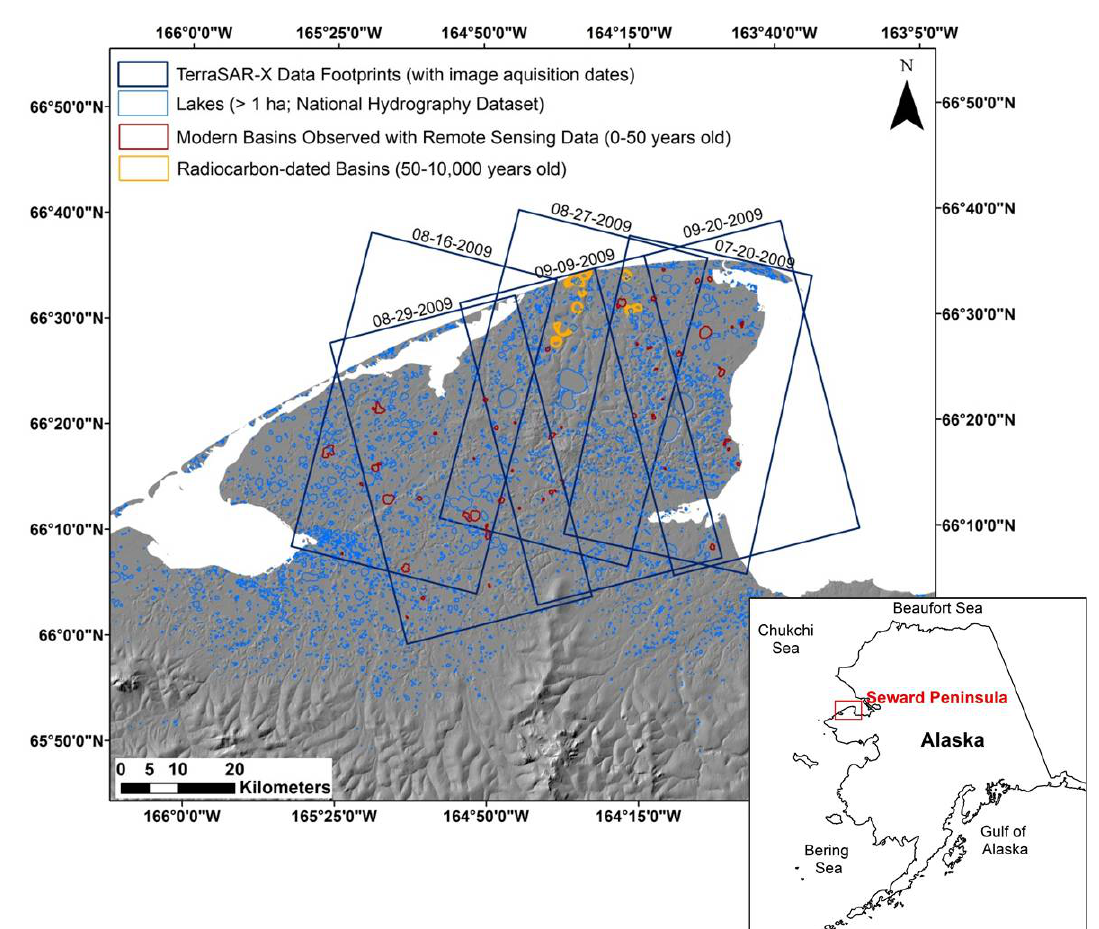
Figure 1. Digital Elevation Model (DEM) base map of the Seward Peninsula showing the location of lakes (>1 ha) mapped in National Hydrography Dataset (NHD) and DTLBs that drained (>90% of surface area loss) 0–50 years ago (based on times series analysis of aerial and satellite images from 1950 to 2010 [43]) and 50–10,000 years BP (based on radiocarbon dating [10]). The footprints of six TerraSAR-X scenes used in analysis are outlined in blue with their respective acquisition